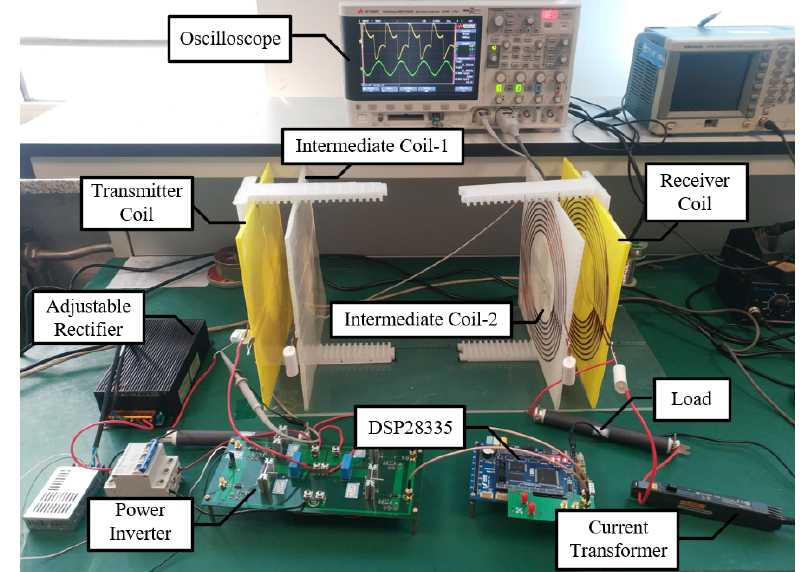
Figure 11. Experimental prototype of the MCR-WPT system with two intermediate